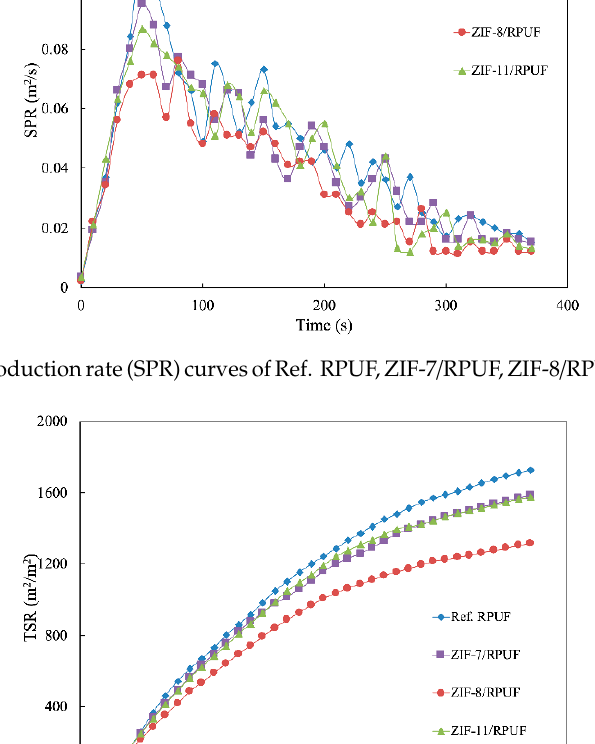
Figure 12. Light absorption of Ref. RPUF, ZIF-7/RPUF, ZIF-8/RPUF and ZIF-11/RPUF.